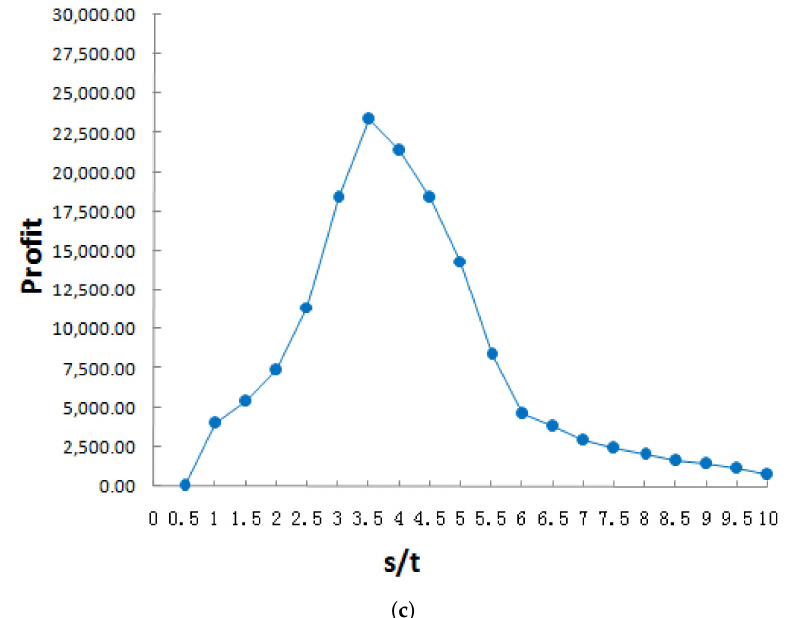
Figure 3. The maximal profit of the DRRPVT with the ratio of base stations to: ( a ) main stations, ( b ) vehicles, and ( c )